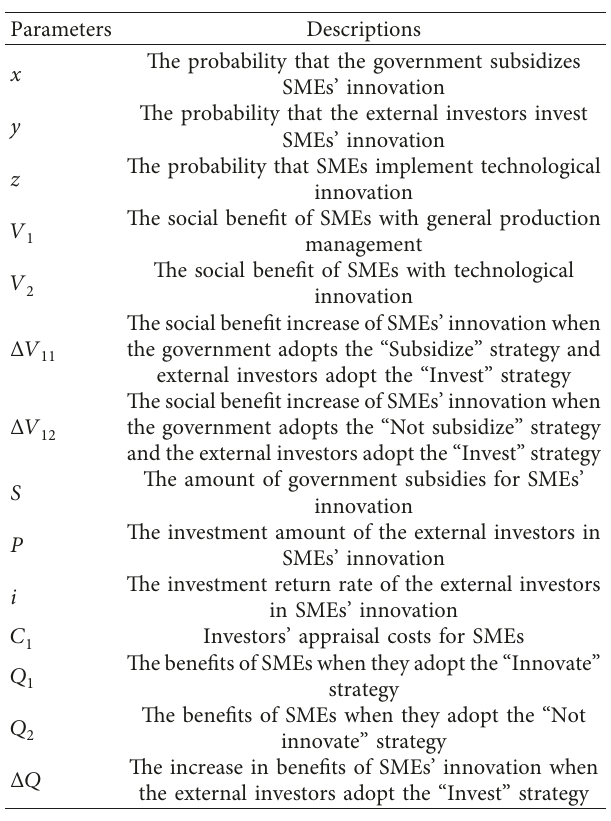
Table 1: Parameter description.